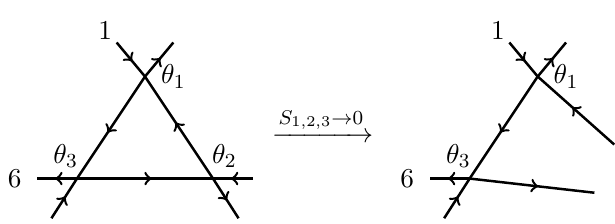
Figure 4. The diagram shows the factorization limit of a six-point diagram, S 1 , 2 , 3 → 0 , which corresponds to taking θ 2 → π/ 2 on the diagram (a) in figure 2, and note that diagram (b) doesn’t develop a singularity in this